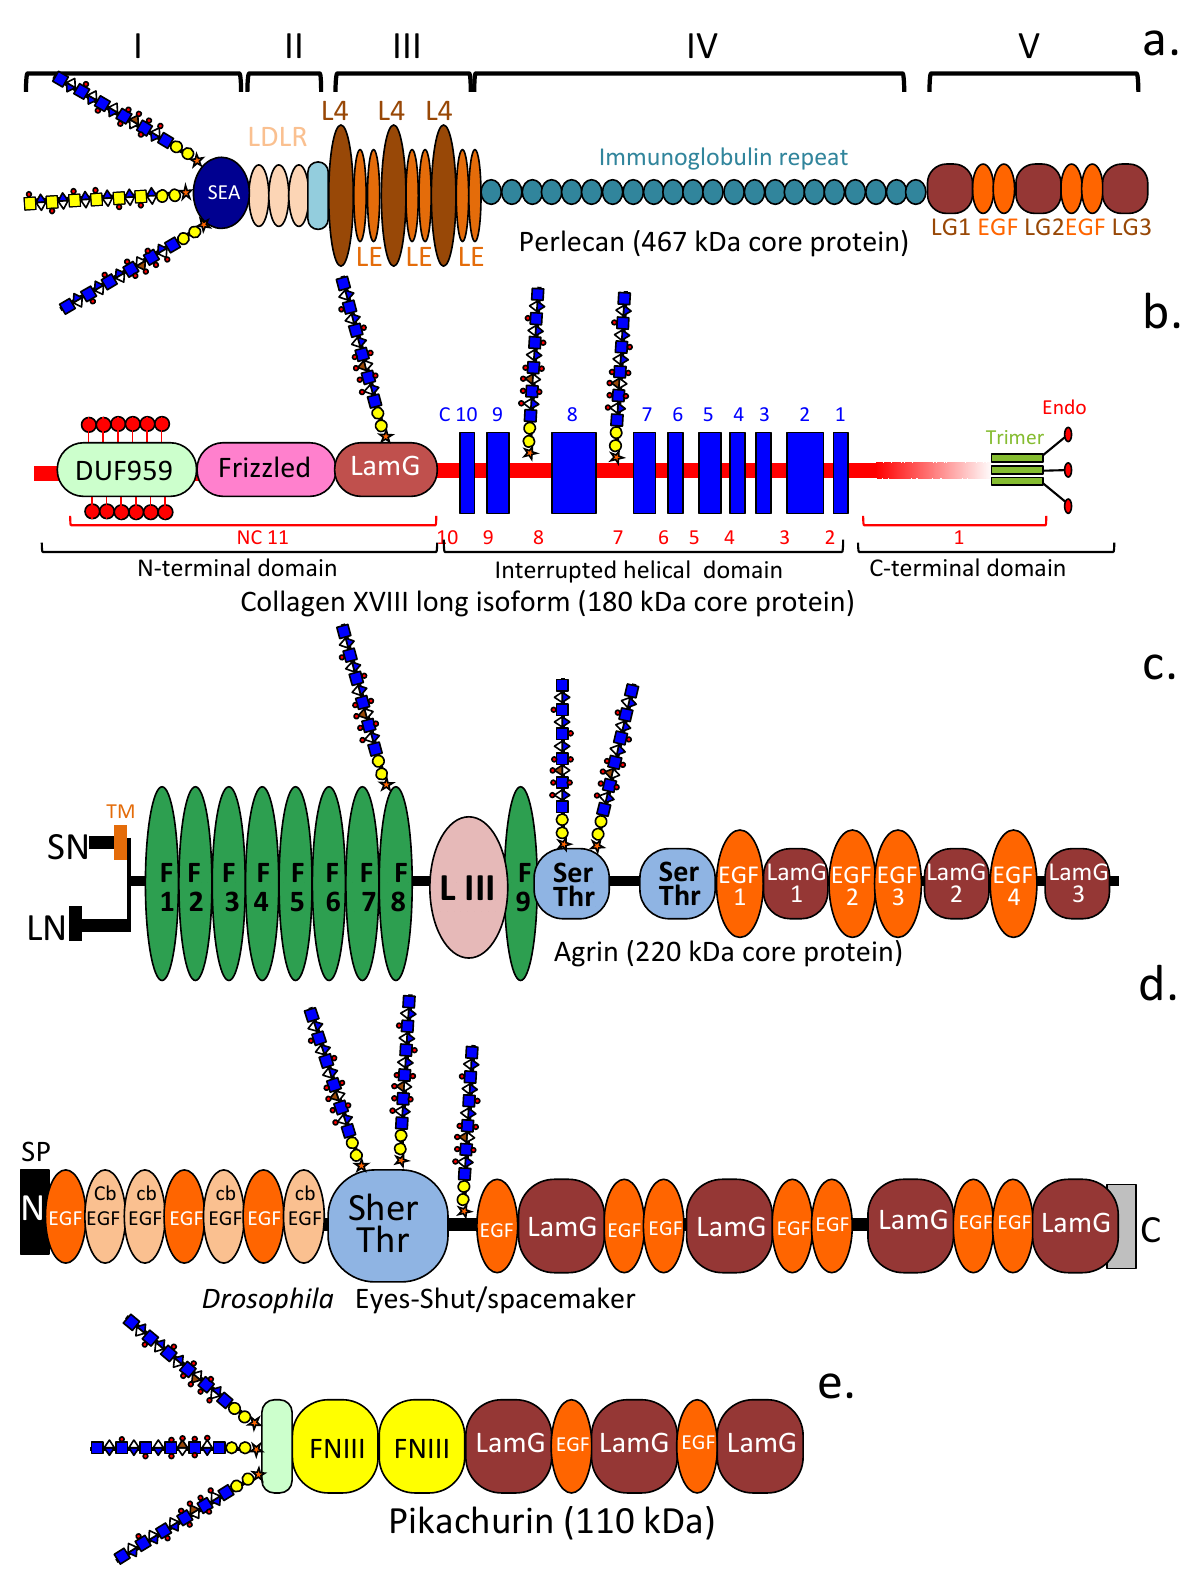
Figure 6. Extracellular HS-proteoglycans and their core protein domain organisations and GAG attachment sites. ( a ) perlecan, ( b ) agrin, ( c ) type XVIII collagen, ( d ) Eyes-shut ( e ) Pikachurin.